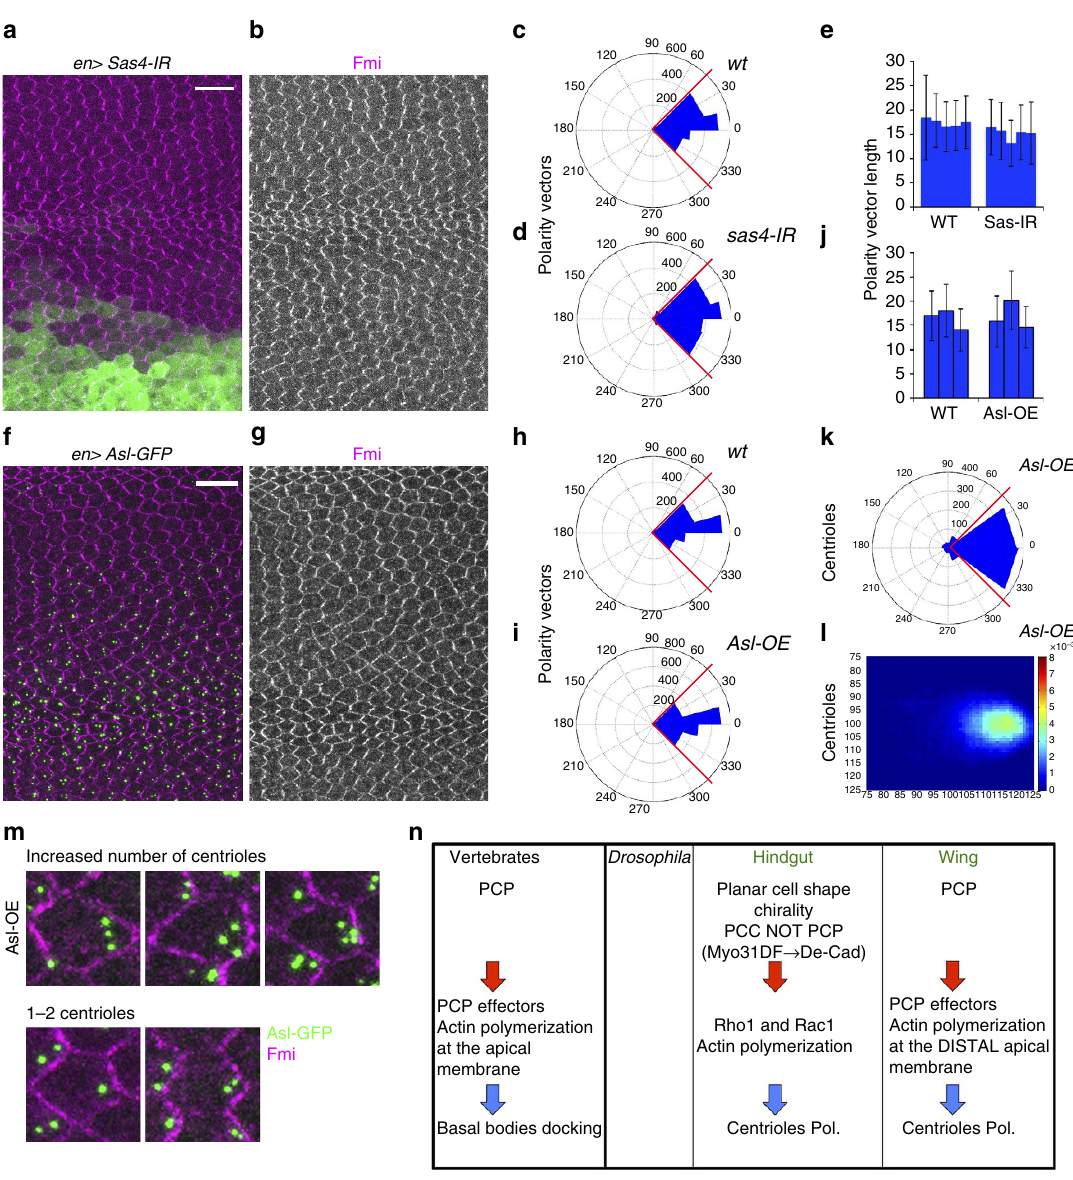
Figure 4 | Loss or gain of centrioles does not affect core PCP factor localization. ( a – e ) Imaging and quantifications (sed Methods) of Fmi staining in Sas4 RNAi-mediated knockdown (in cells marked with GFP) in the posterior compartment in 32–34h APF pupal wings. en 4 Sas4 IR RNAi-mediated KD ( a – b ) did not disrupt Fmi localization as compared with the WT anterior compartment from same wings. ( c , d ) Quantifications of Fmi polarization using polarity vector angle orientation revealed no significant differences between en 4 Sas4 IR ( n ¼ 1,872 cells from five independent wings) and WTcells ( n ¼ 1,513 cells, five independent wings). NS: non-significant ( P ¼ 0.655) ( w 2 -test)). ( e ) Polarity vector lengths (relative to Fmi fluorescence polarization) did not show significant differences between in Sas4 IR cells and adjacent WTcells (five independent wings). NS: non-significant. ( f – j ) Gain of centrioles ( 4 2 per cell) through Asl overexpression ( n ¼ 1,099 cells, three independent wings) in the posterior compartment ( en 4 Asl ), did not affect Fmi localization as compared with wild type from the same wings ( n ¼ 1,096 cells, three independent wings). ( h , i ) Quantification of angle distribution of polarity vectors, and ( j ) polarity vector length. Note no significant changes between wt and en 4 Asl cells ( P ¼ 0.783) ( w 2 -test). ( k – m ) Centriole positioning follows PCP core factor localization even when higher numbers of Asl-positive centrioles are present per cell. Quantifications are depicted in rosette ( k ) and heatmap ( l ) diagrams. ( m , n ) Specific examples of centriole localization in multi-centriolar cells, note several examples with 3–4 centrioles per cell ( m , top), and two Asl-positive centrioles per cell ( m , bottom); in WT only 1 centriole is stained by Asl for comparison (Asl in green; cf. to Fig. 1a,b). In all cases, centrioles remained close to the distal side of each cell (marked with Fmi; magenta). ( n ) Schematic representation of signalling pathways involved in centriole polarization related to planar cell polarity in vertebrates versus Drosophila . Scale bar, 10 m